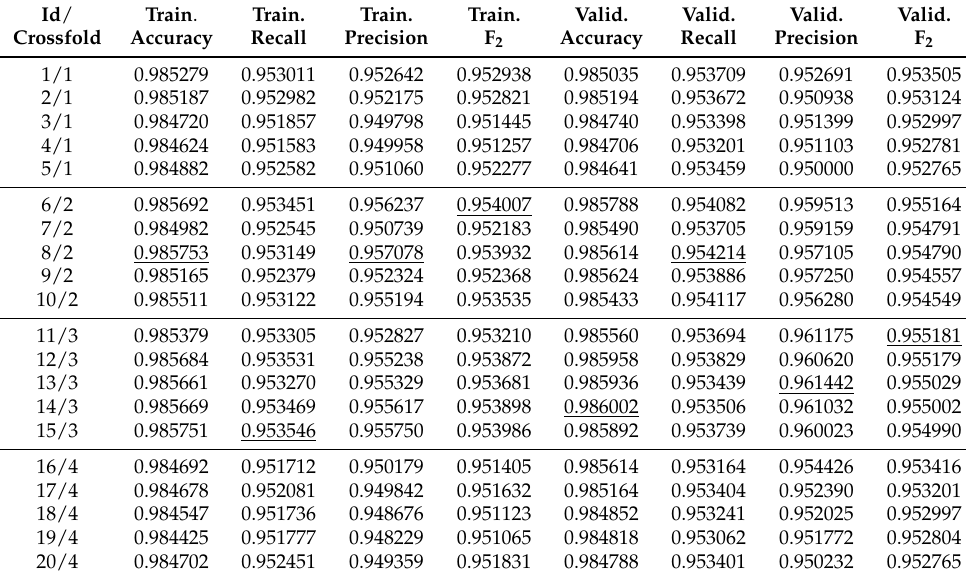
Table 2. The best five results for each crossfold (the highest values are